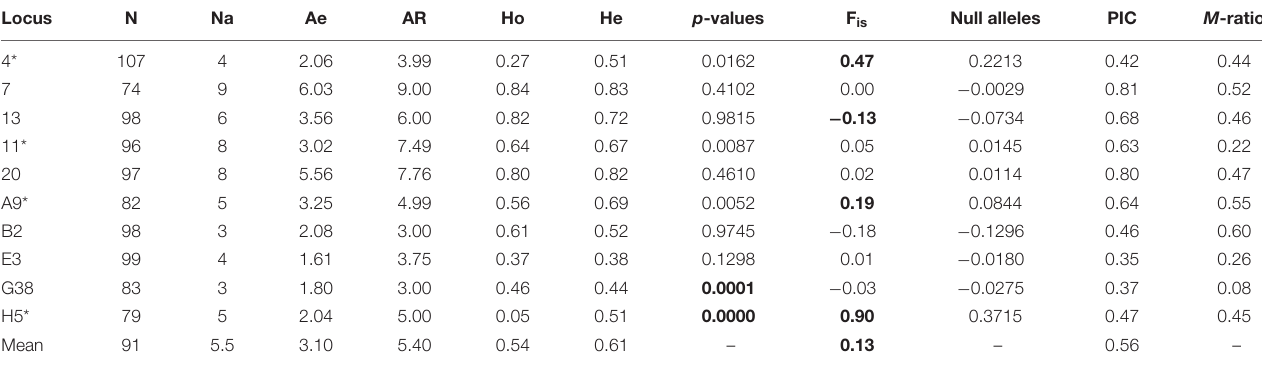
TABLE 1 | Summary information on the 10 microsatellite loci used in Myrmecophaga tridactyla.